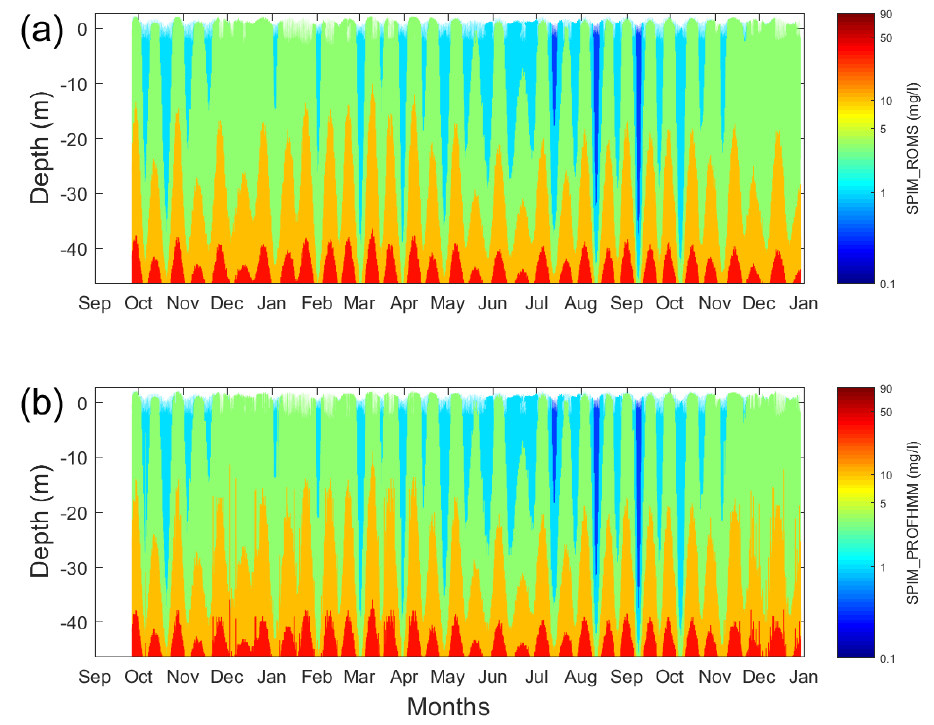
Figure 4. Learning phase of original suspended particulate inorganic matter (SPIM) section from Regional Ocean Modeling System (ROMS) data in ( a ), and corresponding PROFHMM-derived SPIM section in ( b ) from the point M2.